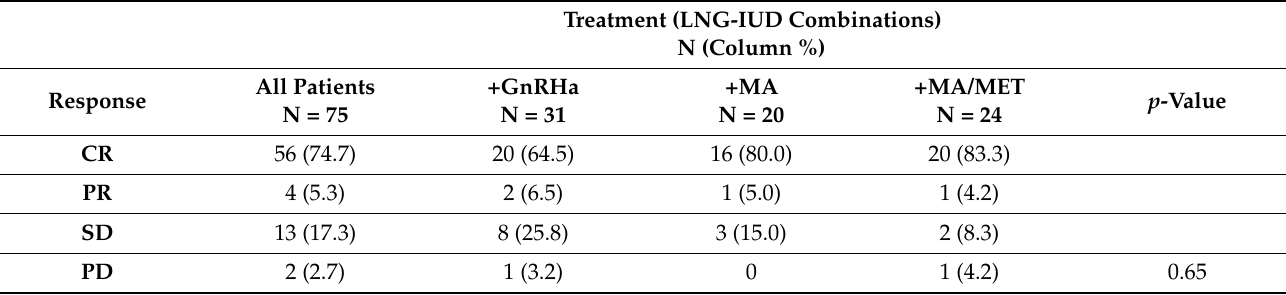
Table 2. Treatment response at 12 months from treatment start. Treatment (LNG-IUD Combinations) N (Column %)